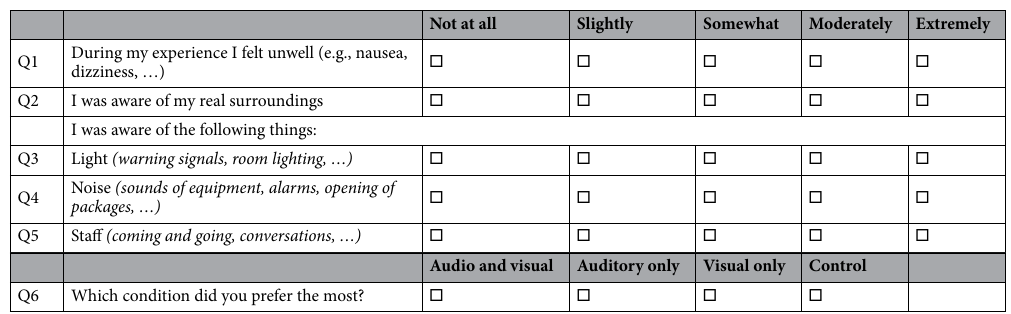
Table 2. Description of Subjective Participant Awareness and Intervention Preference Questions (translated from German). Q1 was asked after each condition except when no artificial sensory inputs were provided. Q2-5 were asked after each of the interventions, and Q6 was asked only after the final intervention was